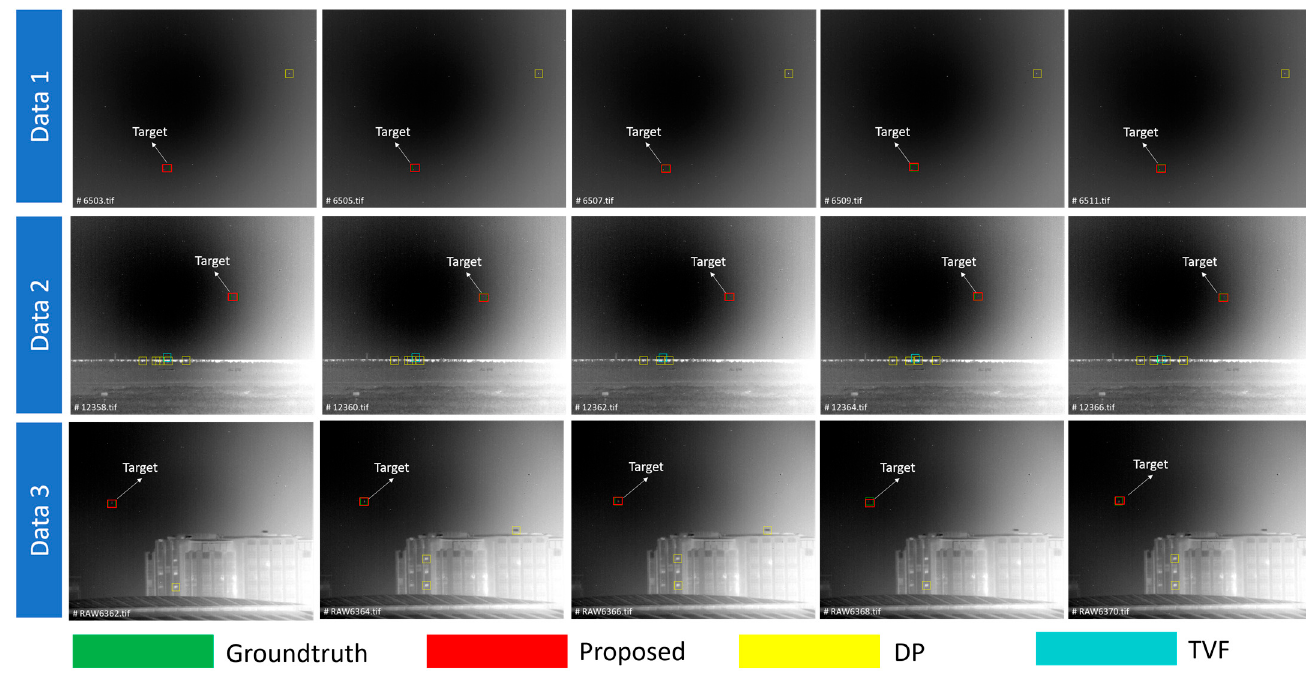
Figure 15. Detection results between our method and traditional multiple-frame-based methods in self-made datasets. The target has been marked by texts, and the other prediction boxes are false alarms. Experimental results show that only the method in this paper achieves continuous detections. The conventional multi-frame algorithm misidentifies the tarmac, the windows, and vegetation as targets.